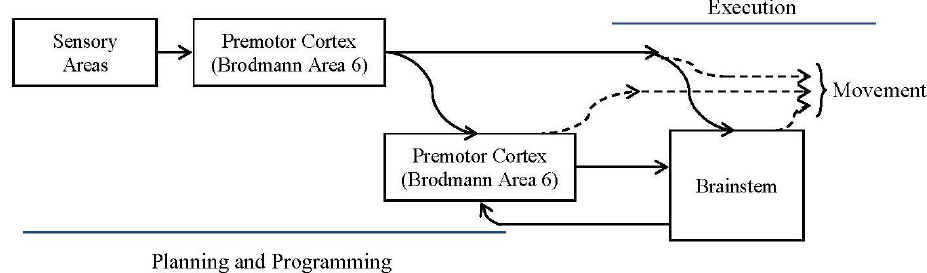
Figure 1. Simplified block diagram for intended movements’ execution. There are two parts: one for the planning and programming (involved in this article) and the second part for the movement execution. In the diagram, the arrows represent the information flows: solid lines are used to represent trajectory information and dotted lines are used to represent movement commands. In this article, the second part has been implemented as a wire; neither feedback has been